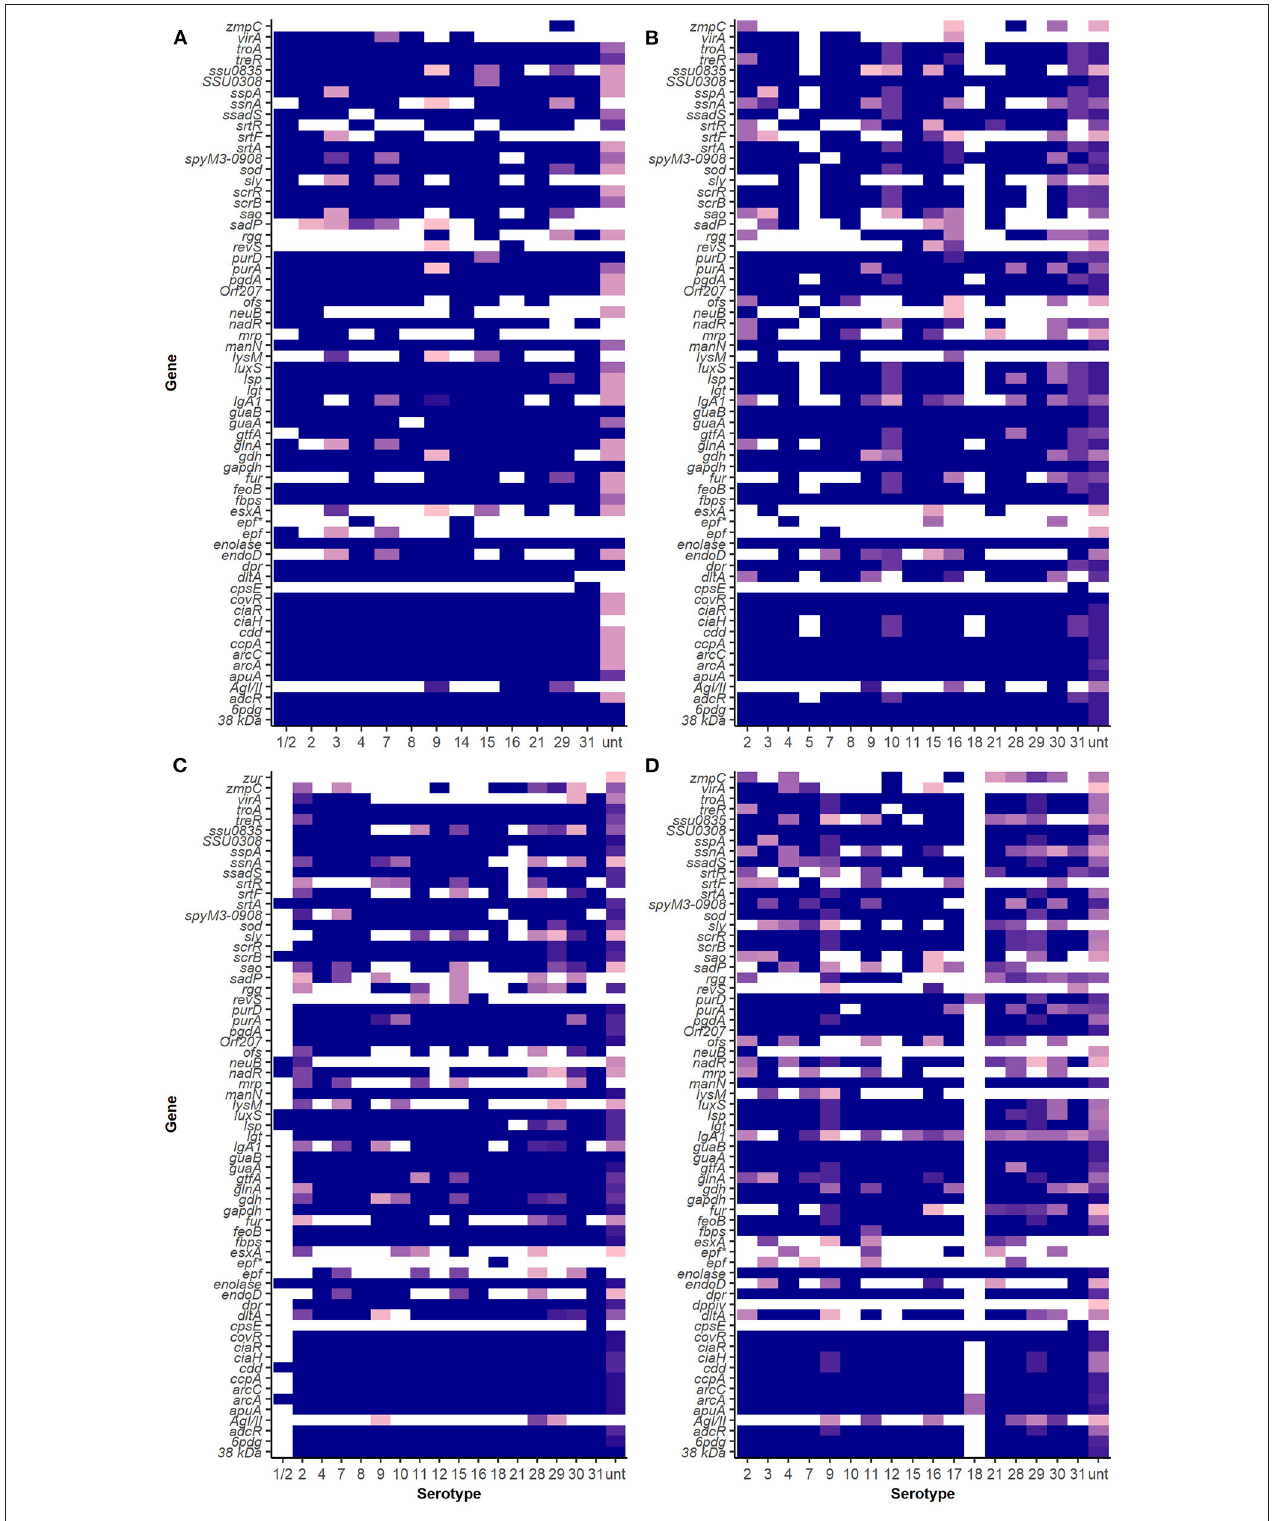
FIGURE 3 | Virulence-associated factor gene distribution among isolates in SC, NSC, NSP, and NSH groups. Darker shades show a higher proportion of isolates of a serotype carrying a particular gene. White indicates an absence of gene in that serotype. (A) Isolates recovered from systemic sites of pigs with confirmed infections (SC), (B) isolates recovered from non-systemic sites of pigs with confirmed infections (NSC), (C) isolates recovered from probable cases (NSP), and (D) isolates recovered from non-systemic sites of healthy pigs (NSH).